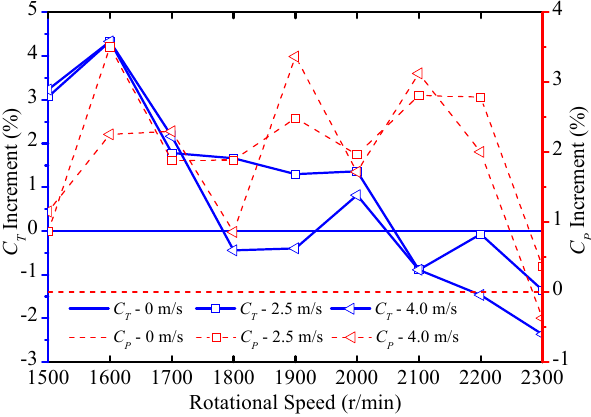
Figure 6. C T and C P increment with different wind speeds.